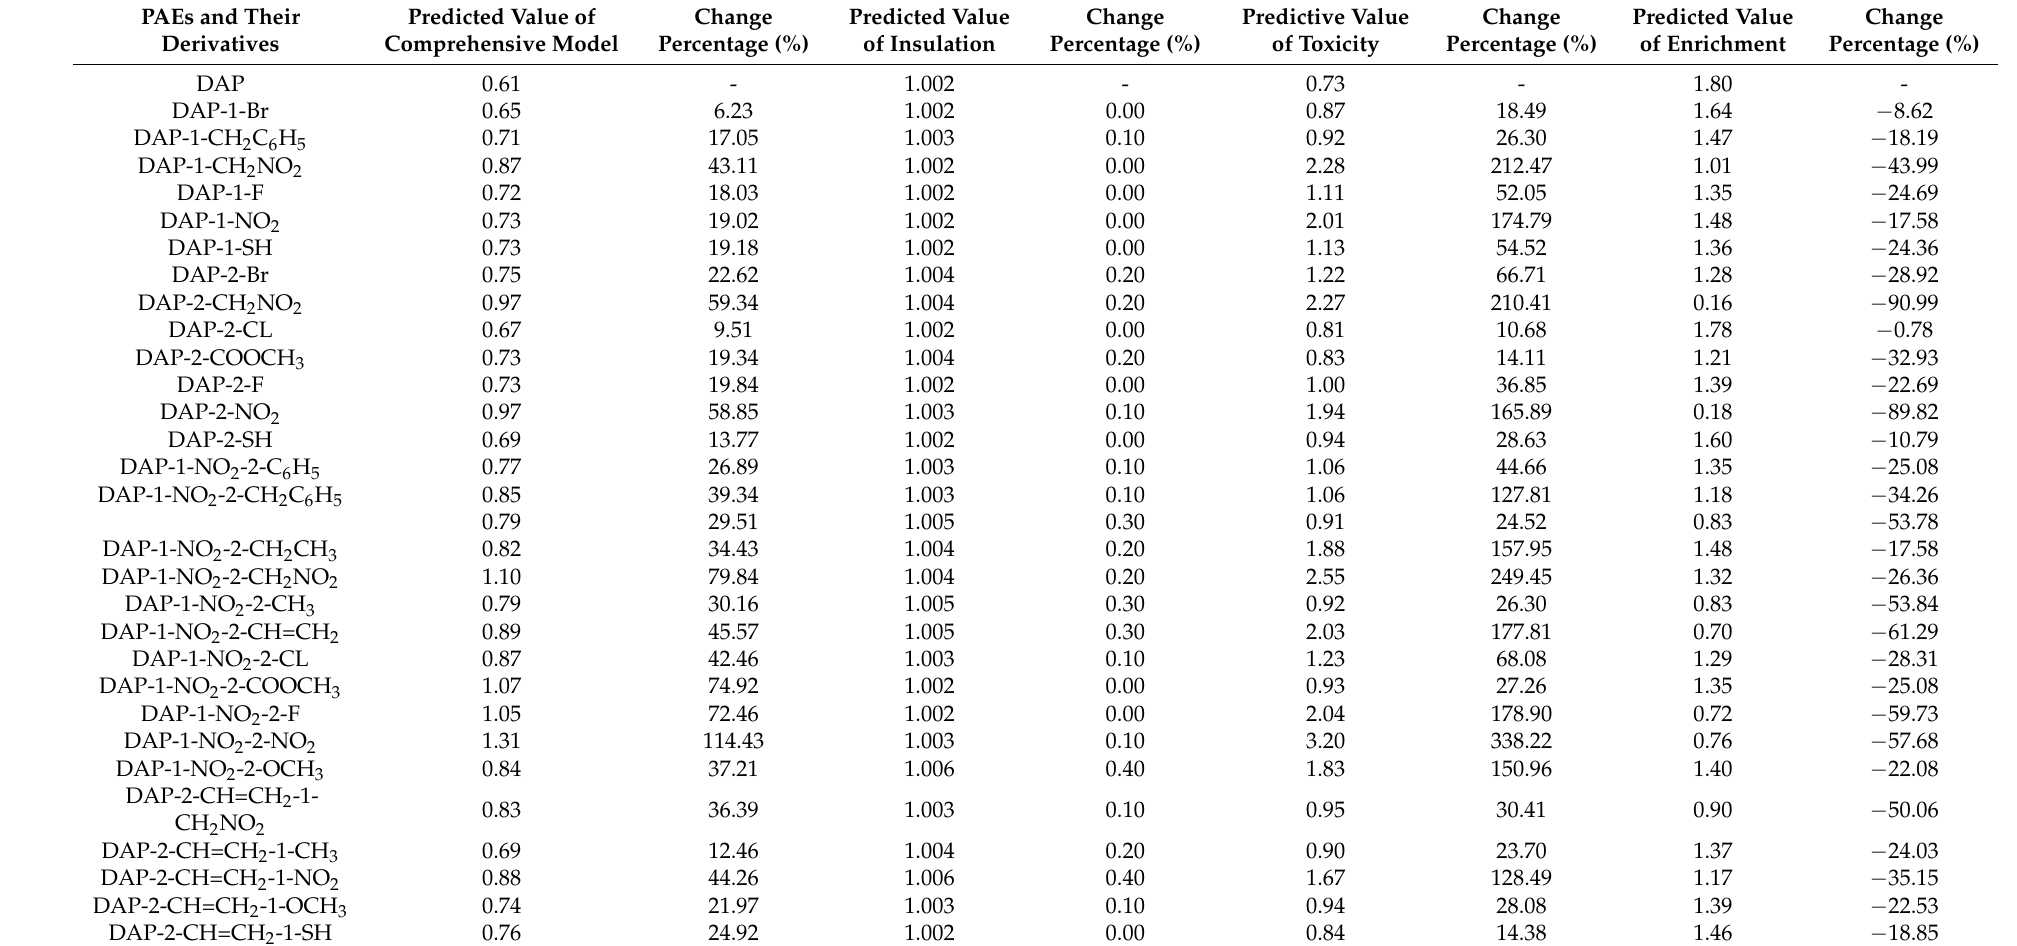
Table 4. The predicted value and percentage change of PAE derivatives based on the 3D-QSAR model of combined and single effects. PAEs and Their Predicted Value of Derivatives Comprehensive